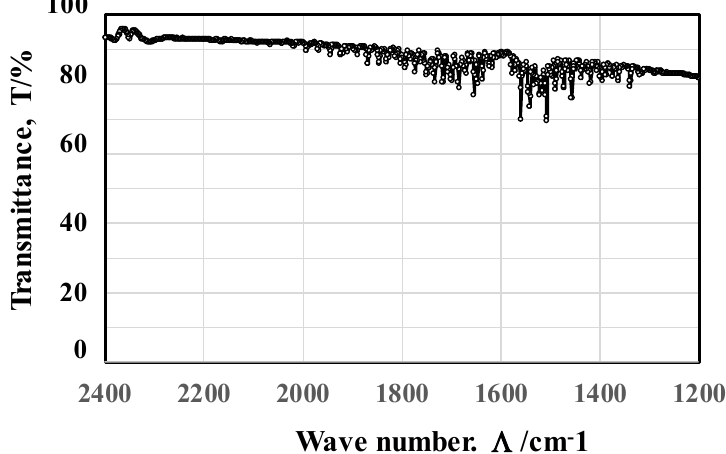
Figure 9. Micro-cone unit height distribution along the scanning line, X, for the LL-specimen.